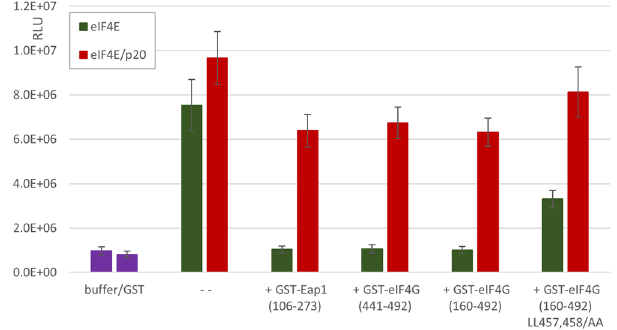
Figure 4. Inhibition of eIF4E-dependent in vitro translation by 4E-binding peptides. 1 pmol eIF4E (green) or 1 pmol eIF4E/p20 (red) was added to in vitro translation reactions containing 5 ng capped GRE1-Luc mRNA. Additionally, 1 pmol of the following purified GST-fusion proteins were added: GST-Eap1 106–273 , GST- eIF4G 441–492 , GST-eIF4G 160–492 and GST-eIF4G 160–492 LL457,458/AA. 1 pmol GST alone had no stimulatory effect on translation. Data presented are the mean luminescence activity in relative light units (RLU ± s.e.m.; n = 3).